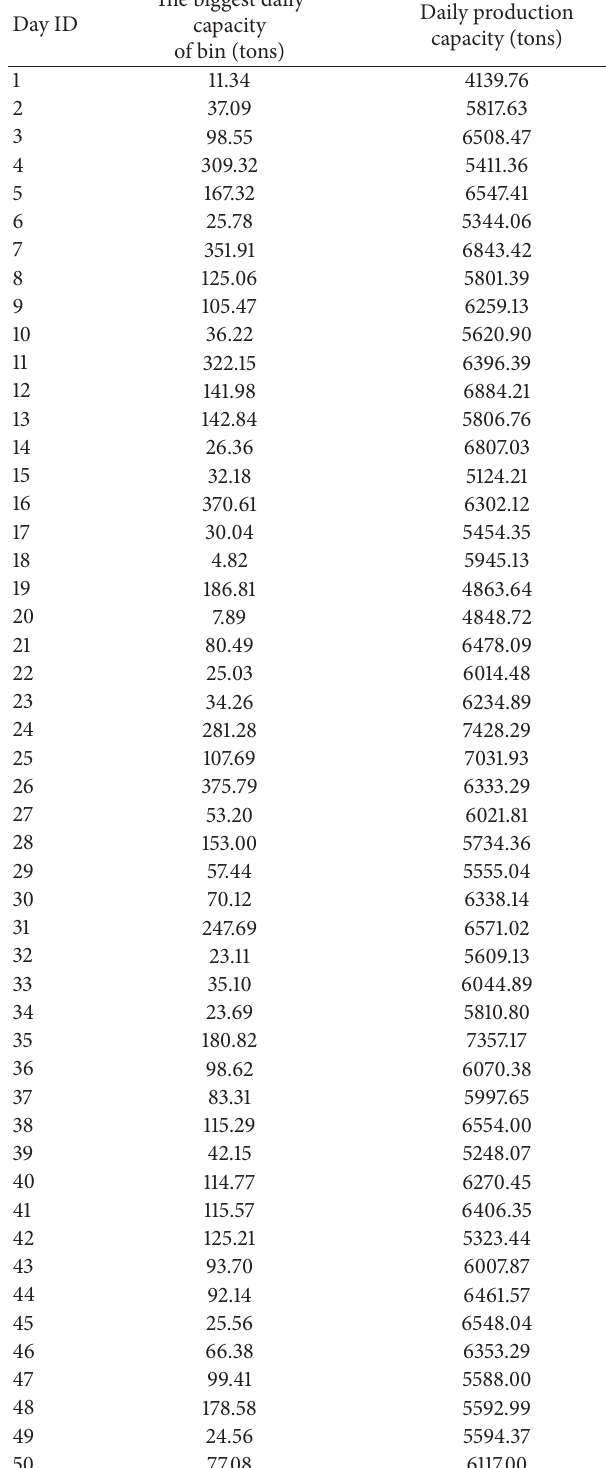
Table 2: The first output result of the simulation